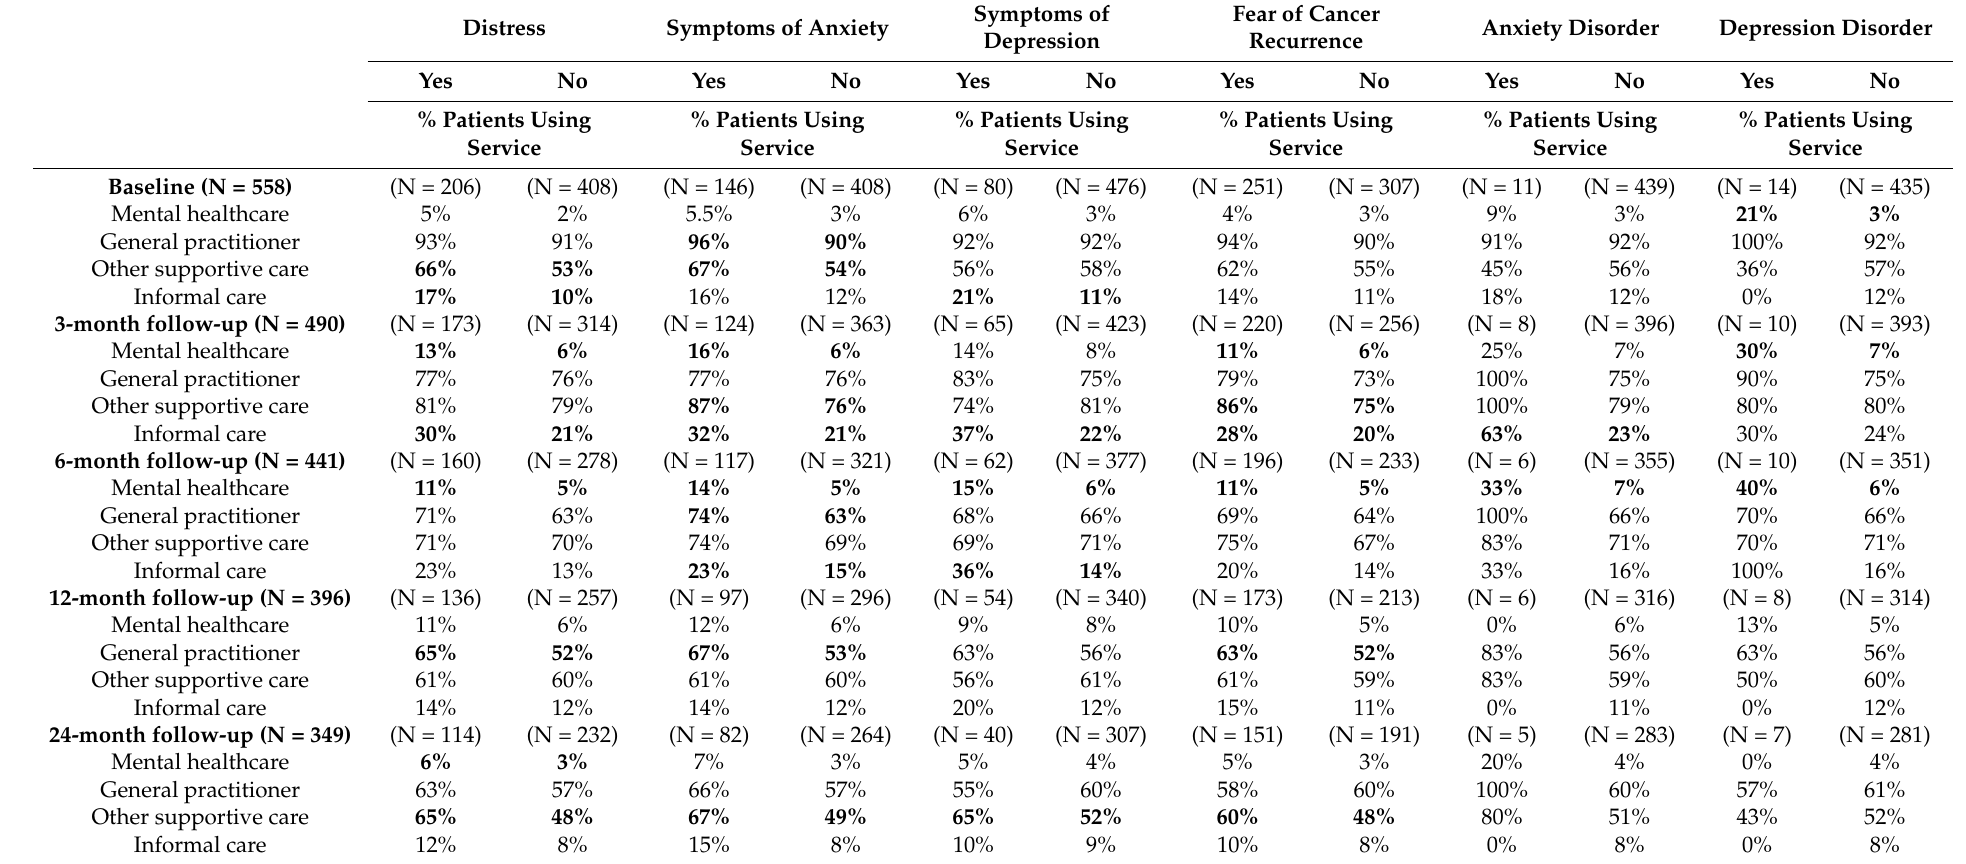
Table A1. Psychological problems at baseline in relation to healthcare use at baseline, 3-, 6-, 12-, and 24-month follow-up. Distress Symptoms of